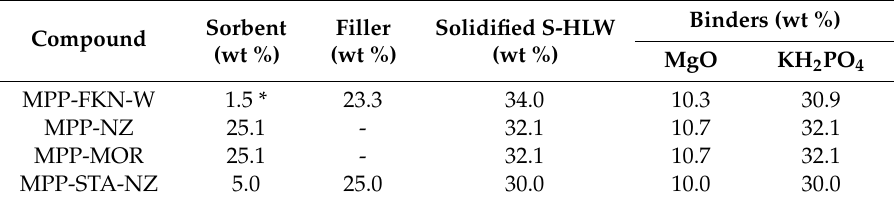
Table 1. Composition of synthesized MPP compounds.